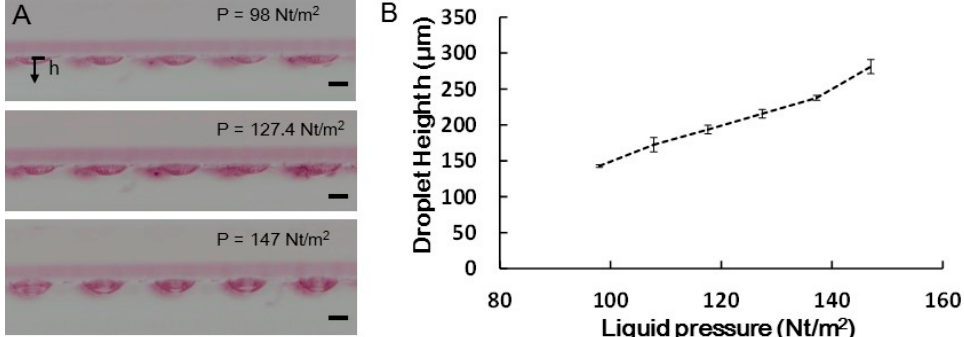
Figure 2. Measured droplet heights under various hydrostatic pressures in μ HD chip with 1000 μ m diameter opening wells. ( A ) Side-view photographs of a portion of the μ HD chip showing protruding droplets of different heights (top: average height = 142.8 μ m at 98 N/m 2 ; middle: average height = 215.6 μ m at 127.4 N/m 2 ; bottom: average height = 281.2 μ m at 147 N/m 2 ; ( B ) the relationship between the droplet height and hydrostatic pressure. Scale bar is 500 μ m.